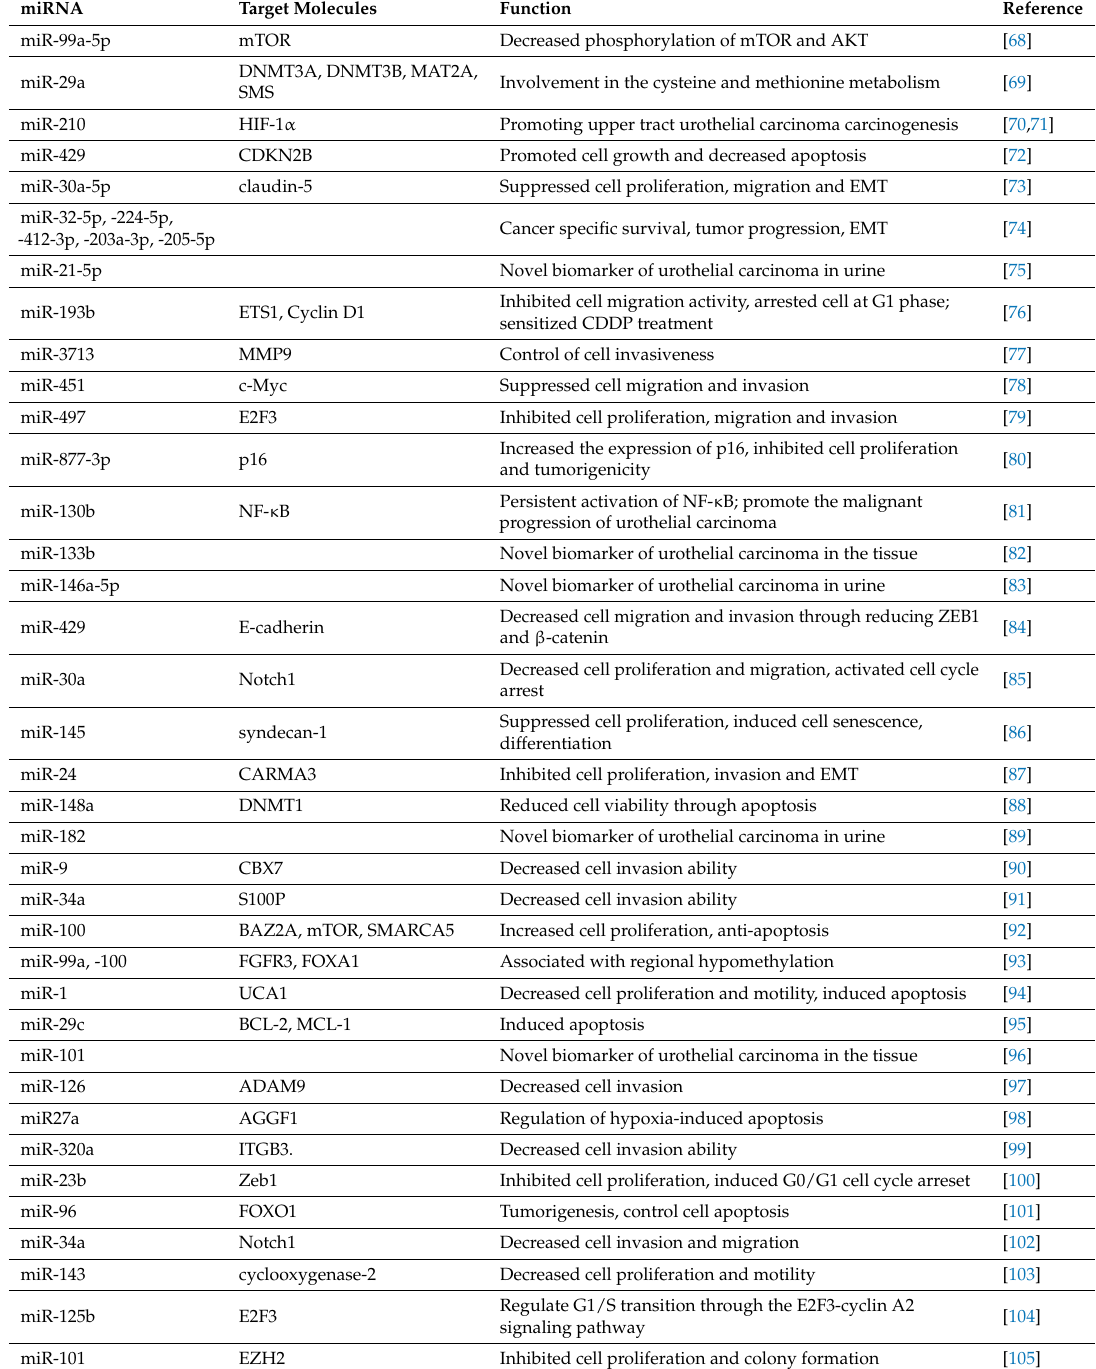
Table 1. Relationship between the microRNA (miRNA) and mRNA of target